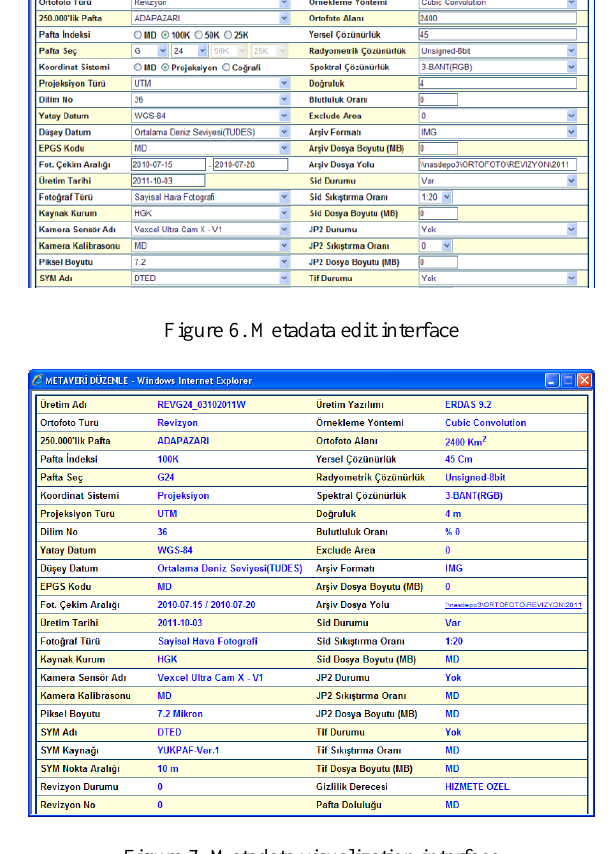
Figure 7. Metadata visualization interface